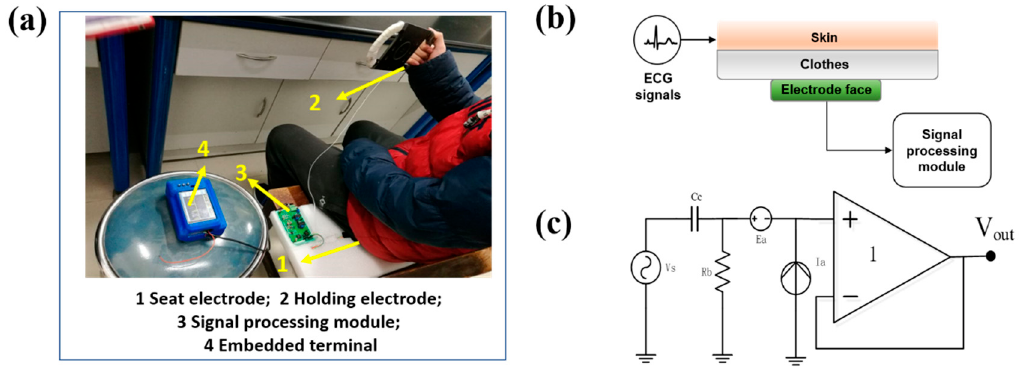
Figure 1. ( a ) Non-contact ECG monitoring system; ( b ) Schematic diagram of the capacitive coupling electrode; ( c ) Equivalent circuit diagram of the electrode.